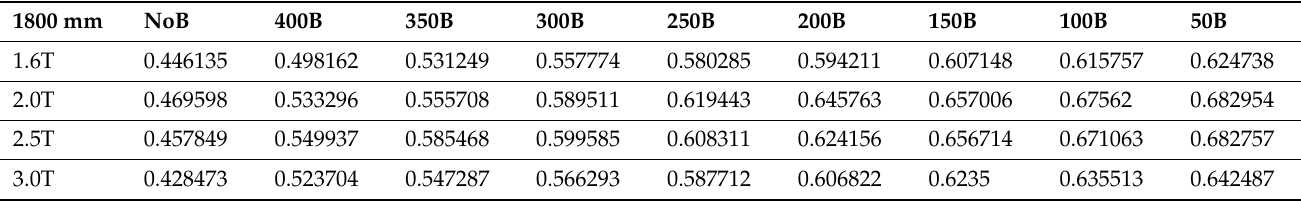
Table 4. Ultimate normalised compressive capacities for 1800 mm models based on reinforcement